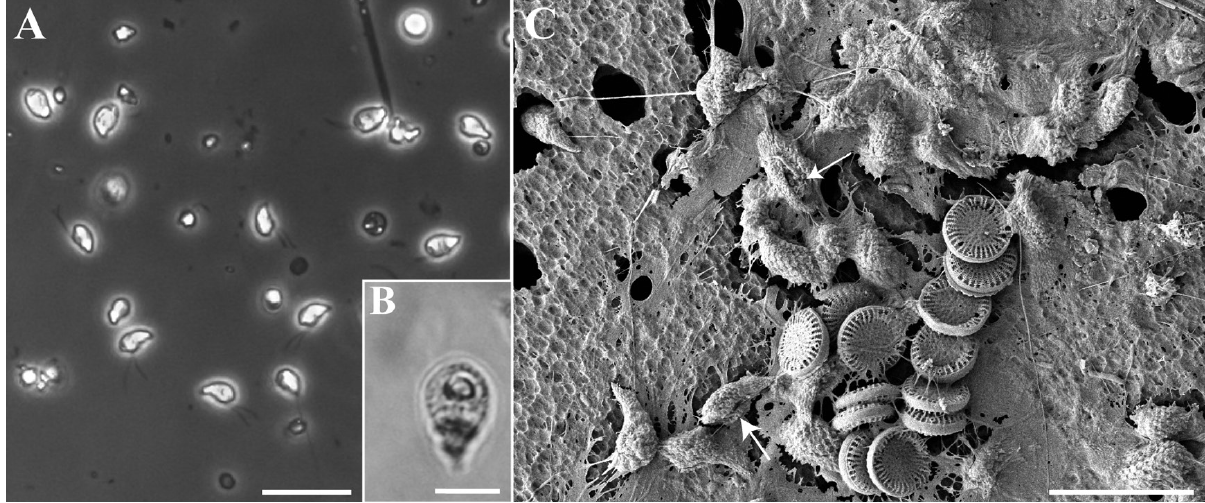
Fig. 7. – Images of Plagioselmis cf. prolonga taken with the light (A, B) and scanning electron (C) microscope. A, dominance of characteristic tear drop-like cells in the samples from station E4a (phase contrast); scale, 20 µm. B, cell with the centrally placed pyrenoid (differential interference contrast); scale, 10 µm. C, aggregates containing Plagioselmis cf. prolonga and nanoplanktonic centric diatoms. Hexagonal plates are visible on all cells. Furrow is visible on cells that are lying on dorsal side (arrows); scale, 10